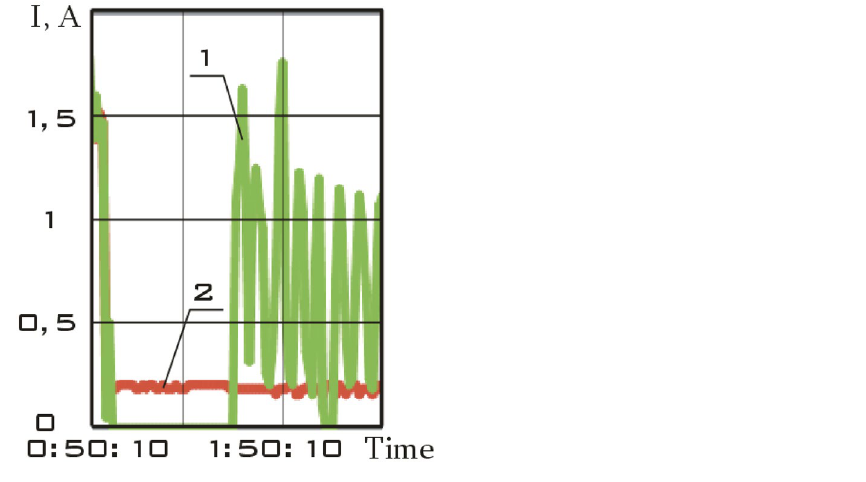
Figure 7. There is dynamics of currents in the power supply system of the small spacecraft prototype "Aist" according to telemetry data from 01/11/2014: 1 is battery charging current; 2 is current of power consumption of scientific